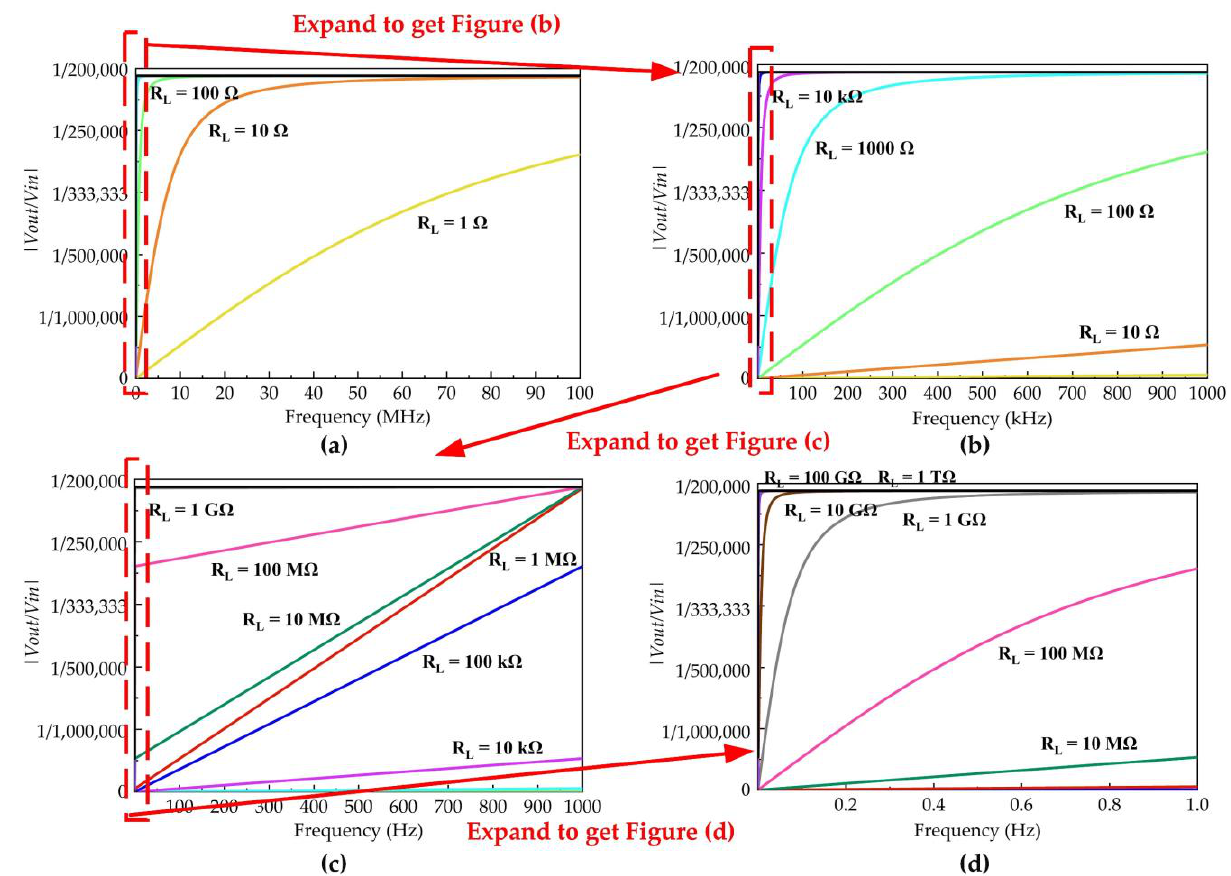
R on the ratio of input volt- Figure 3. The Influence of frequency f and equivalent resistive load R L on the ratio of input voltage L